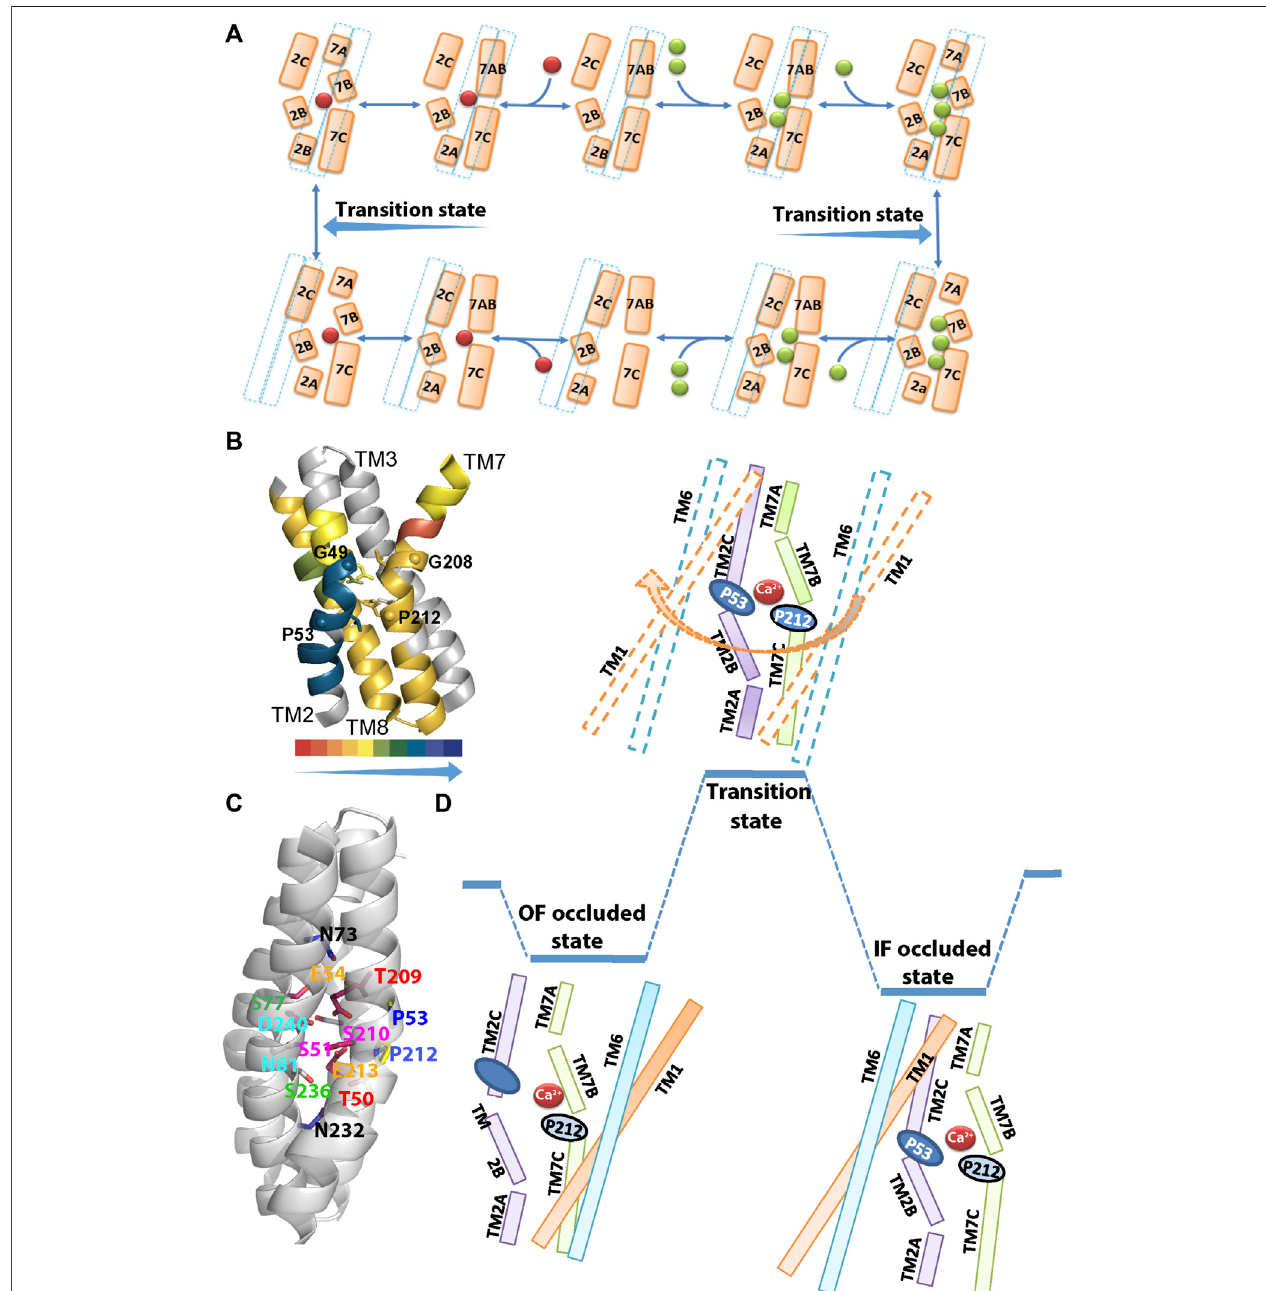
FIGURE 2 | Structural organization of ion binding sites in NCX_Mj. (A) The Na + /Ca 2+ exchange cycle involves a separate translocation of the 1Ca 2+ - and 3Na + - bound species. Green and red spheres denote the Na + and Ca 2+ ions, respectively, whereas a dashed line denotes the sliding cluster (TM1/TM6). According to this model, the transition state is situated between the two occluded states, where the sliding event of the TM1/TM6 cluster takes place during the transition state and it is associatedwiththeOF/IFswappingineitherdirection. (B) Thebackbonedynamicsofthefourion-coordinatinghelicesofNCX_Mjarerepresentedbytheoverlayof the HDX-MS hit maps (Giladi et al., 2017) on the crystal structure of 3Na + -bound NCX_Mj (5HXE). The arrow direction indicates the increased rigidity of the backbone dynamics (the color key shows the percentage of deuterium incorporation). Notably, the backbone dynamics of TM2B is much more constrained than the other ion- coordinatingsegments(TM2C,TM7B,TM7C,andTM8A).Thus,thehelix-breakingresidues(G49,P53,G208,andP212)belongingtotheGTSLPErepeats(allocatedat the interface of the TM2B/TM2C and TM7B/TM7C segments) may speci fi cally shape the local backbone dynamics at “ catalytic ” ion-coordinating residues. (C) Single- point mutations of residues allocated at TM2B, TM2C, TM3A, TM7B, TM7C, and TM8A differentially affect the rate-equilibrium relationships of bidirectional ion movements (Giladi et al., 2016a; Giladi et al., 2016b; Giladi et al., 2016c; van Dijk et al., 2018). Inversely matched pair residues (shown in the same colors) differentially affect the ion transport activities, thereby suggesting that the functional asymmetry of inversely located pair residues occurs at the single residue level. (D) The occluded